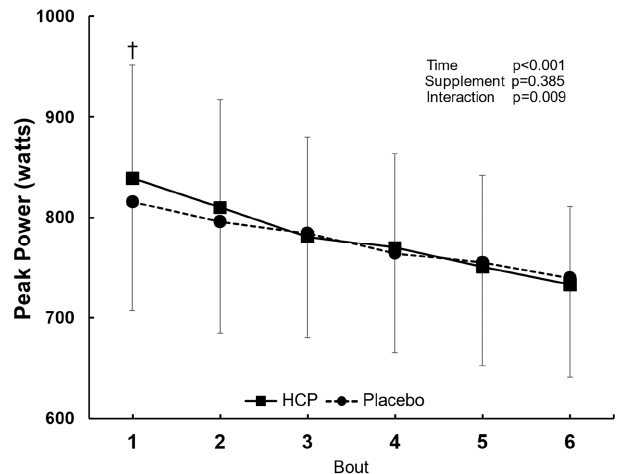
Figure 4. Peak power (PP) output in the 7 s all − out bout during the six repetitions of the HIIT exercise in the HCP and placebo groups. Error bars: SD. † p < 0.01. The PP increased significantly in the 1st bout with HCP compared to the placebo, but no significant difference occurred after that from bouts 2 to 6.